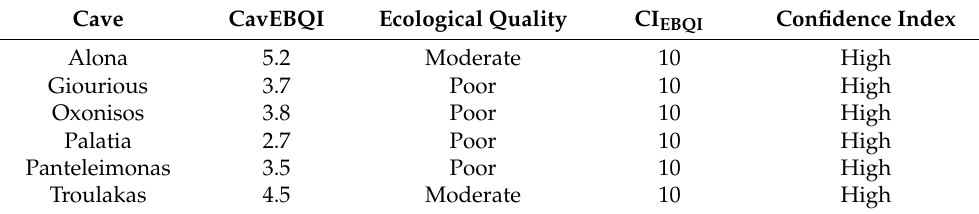
Table 4. Results of ecological quality index CavEBQI and Confidence Index CI EBQI for the six studied caves. Cave CavEBQI Ecological Quality CI EBQI Confidence Index Alona 5.2 Moderate 10 High Giourious 3.7 Poor 10 High Oxonisos 3.8 Poor 10 High Palatia 2.7 Poor 10 High Panteleimonas 3.5 Poor 10 High Troulakas 4.5 Moderate 10